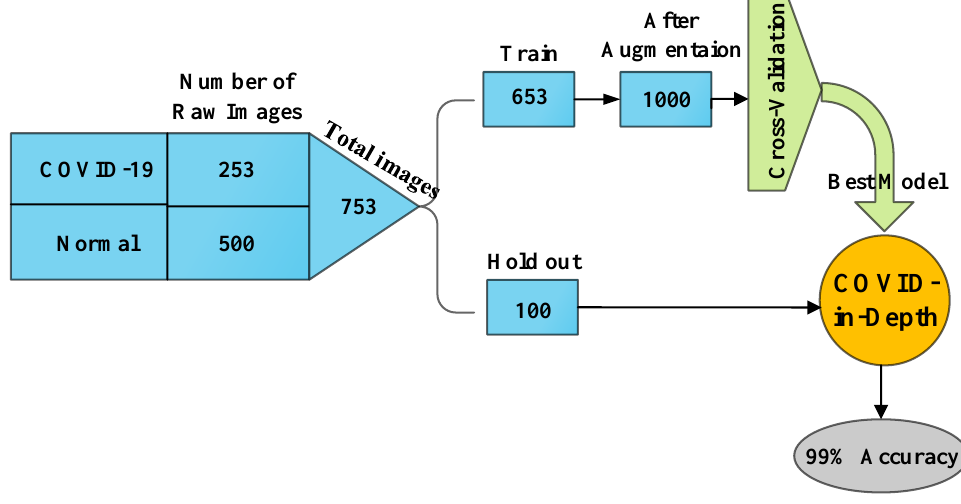
Figure 5. Schematic diagram of the process.